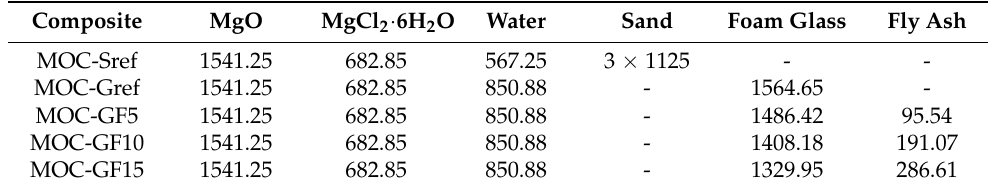
Table 1. The dosage of the components